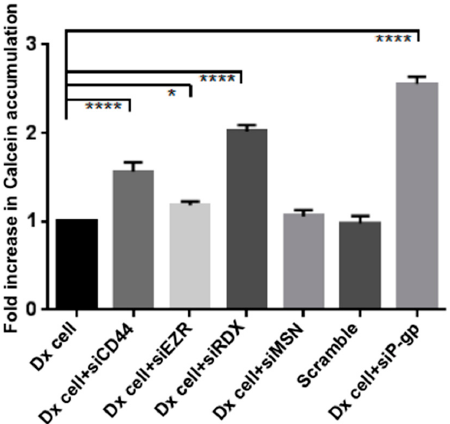
Figure 3. Gene silencing of ERM and CD44—Effect on drug efflux in MCF-7/Dx cells. Dx-cells were silenced with siRNA targeting CD44 (siCD44), Ezrin (siEZR), Radixin (siRDX), Moesin (siMSN) and P-gp (siP-gp) over three days and drug efflux evaluated using FCM. Data represents mean ± SD (n = 3). * p < 0.05, **** p < 0.0001.